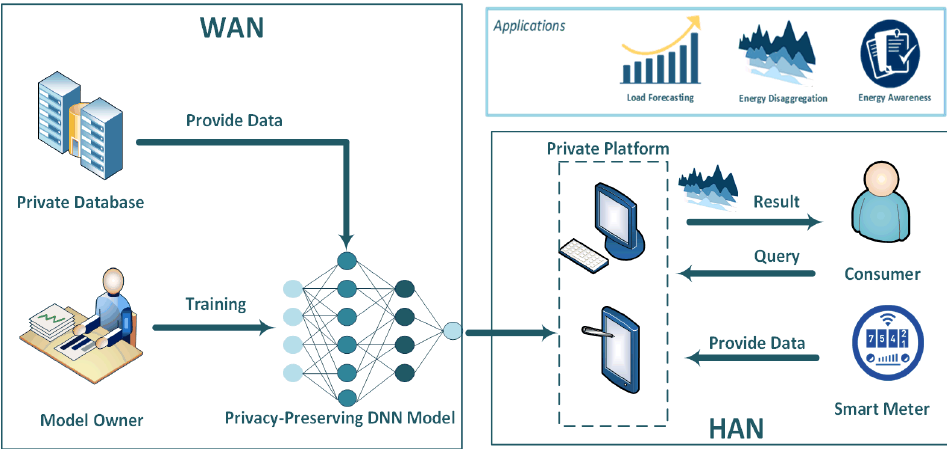
Figure 4. Privacy-preserving valued-added services .